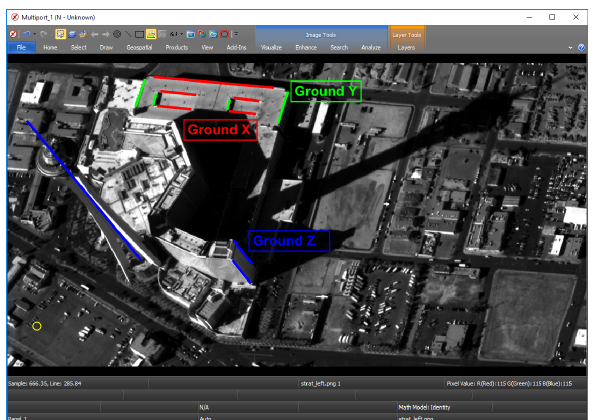
Figure 10. Stratosphere Tower, imagery chipped from WorldView-1 and marked with chosen ground origin (yellow marker) and coordinate axes. A second chip is also used, collected from a perspective such that the layover of the tower is to the